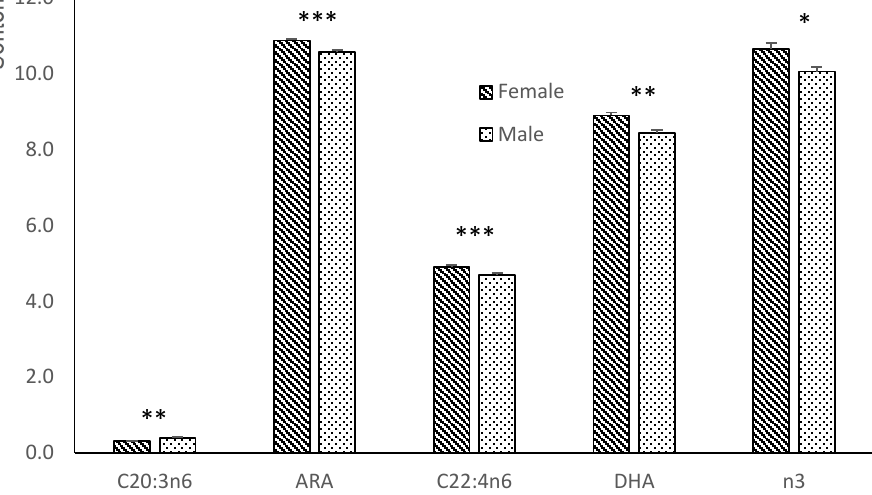
Figure 6. Significant differences in the n3 and n6-PUFA series of the polar fraction of the brain between female and male fetuses obtained at 100 days of gestation born from control gilts or from gilts treated with hydroxytyrosol and linseed oil from day 35 to day 100 of gestation. ARA = arachidonic acid; DHA = docosahexaenoic acid; n3 = sum of n3-PUFA. * p < 0.05; ** p < 0.01; *** p < 0.001.